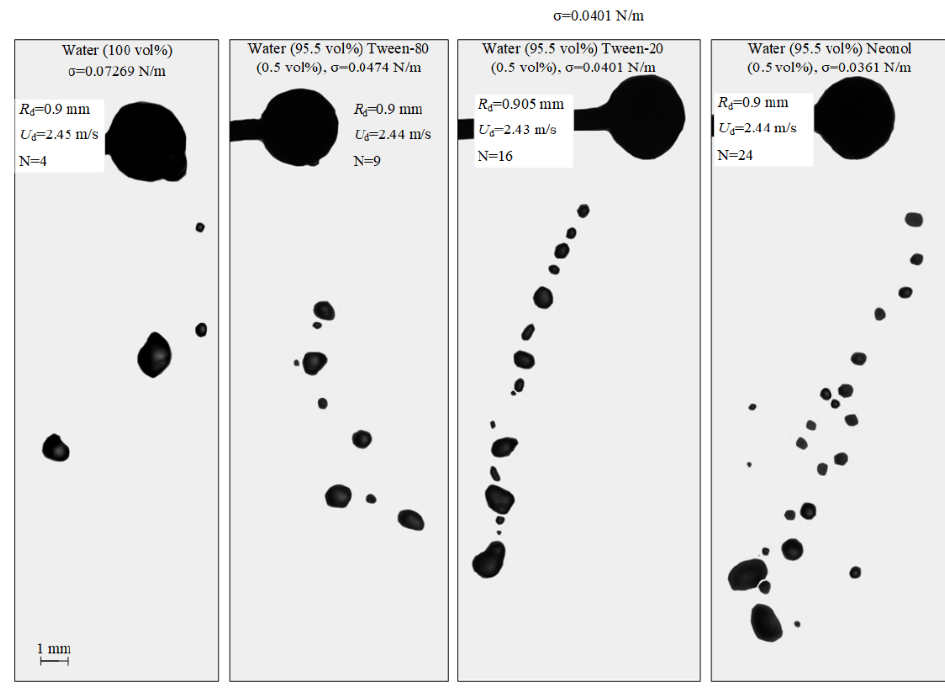
Figure 6. Images illustrating the collisions of liquid droplets with a particle in the stretching separation regime at varying liquid surface tensions.